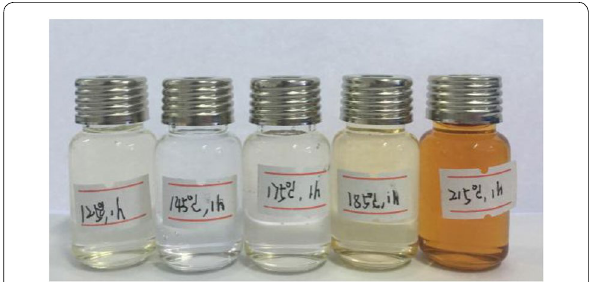
Fig. 1 The condensable effluent samples collected at different heat-treatment